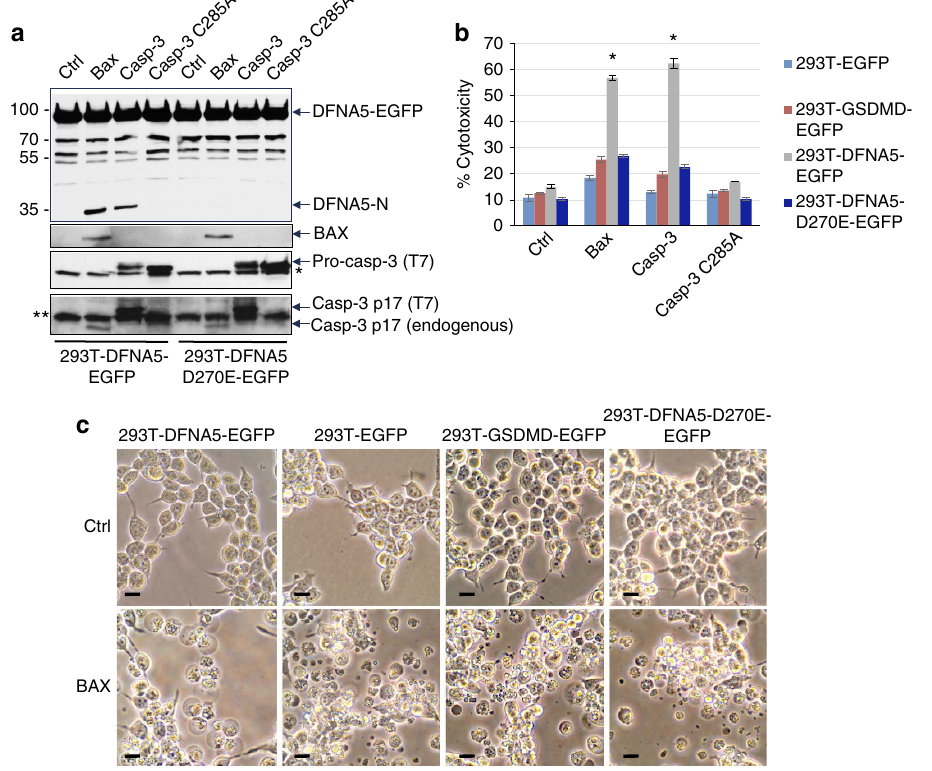
Figure 5 | Activation of DFNA5 downstream of the mitochondrial apoptotic pathway. ( a ) Immunoblots of cell lysates from stable 293T-DFNA5-EGFP and 293T-DFNA5-D270E-EGFP cells transfected with vector control (Ctrl) or constructs for Bax, constitutively active T7-tagged caspase-3 (casp-3) or inactive caspase-3 (casp-3-C285A) for 24h as indicated. The blots were probed with anti-DFNA5 (upper), anti-Bax (middle), or anti-caspase-3 (lower two panels) antibodies. Asterisk indicates endogenous procaspase-3. Double asterisks indicate non-specific band. ( b ) Cytotoxicity of Bax and constitutively active caspase-3 as measured by LDH release in the culture supernatants of the indicated 293T cell lines. ( n ¼ 3) * P o 0.0001), Student’s t -test. ( c ) Microscopic images of the indicated 293Tcell lines transfected with a vector control (Ctrl) or an expression construct for full-length Bax (BAX). Scale bar, 20 m m. Results are representative of at least three independent experiments. Error bars represent standard error of the mean